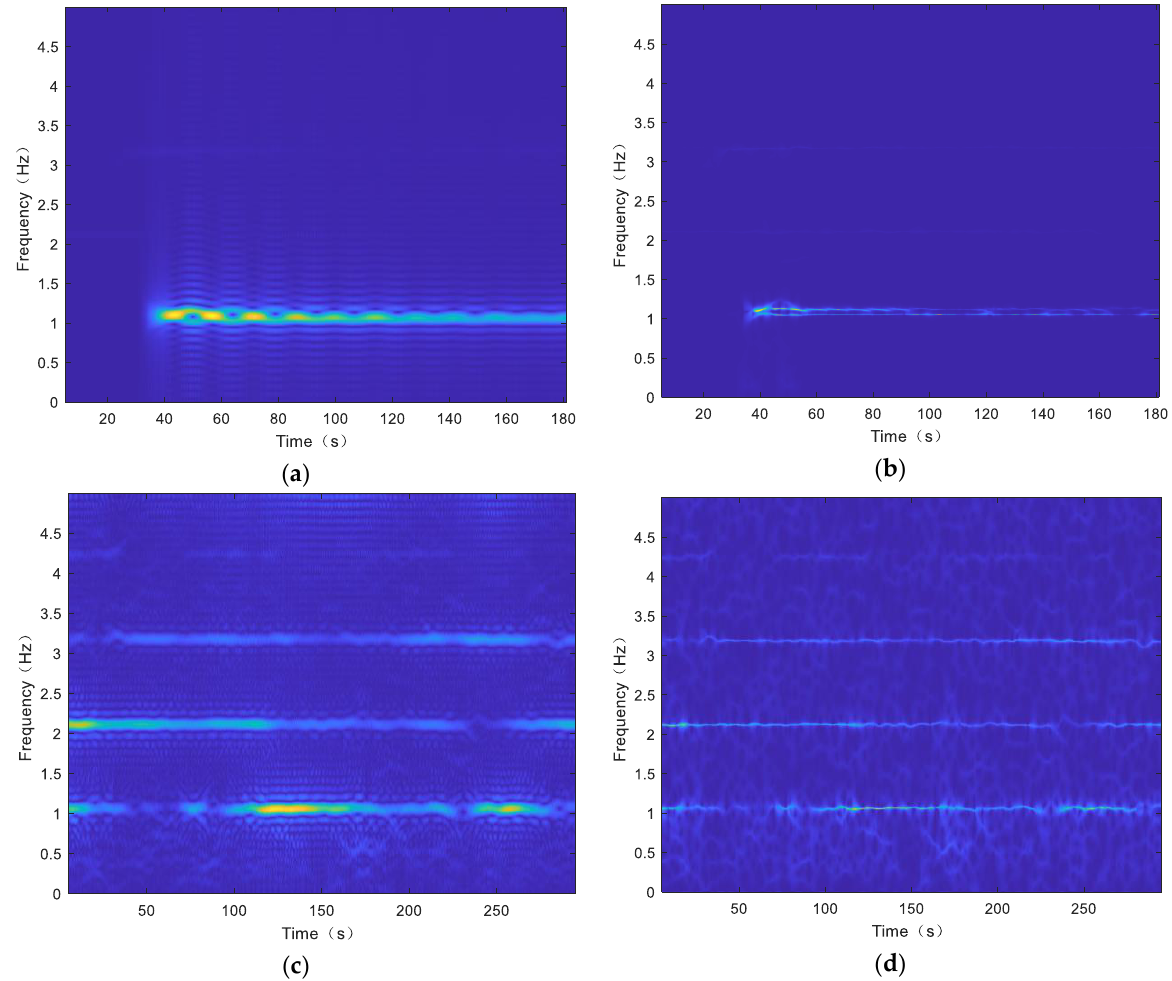
Figure 10. Time-frequency distribution of the longest cable. ( a ) Result of CZT-based STFT and ( b ) result of APES-based time-frequency distribution, when a train passes by for 35 s and 40 s. ( c ) The result of CZT-based STFT and ( d ) result of APES-based time-frequency distribution, when the bridge is on a free condition.